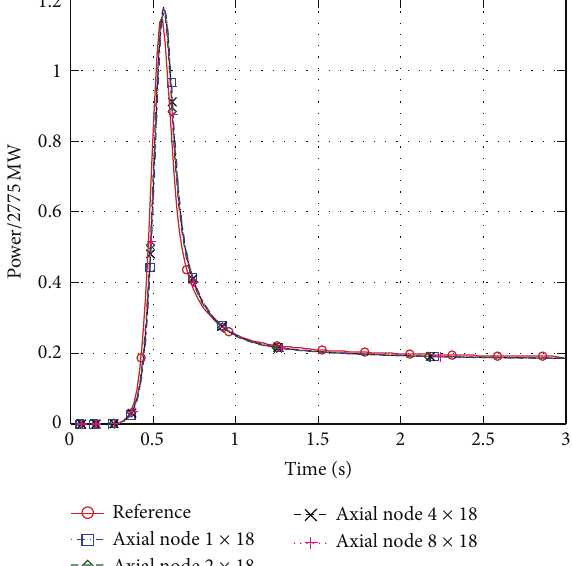
Figure 5: Effect of radial node number per assembly on the maximum fuel centerline temperature for case A2.